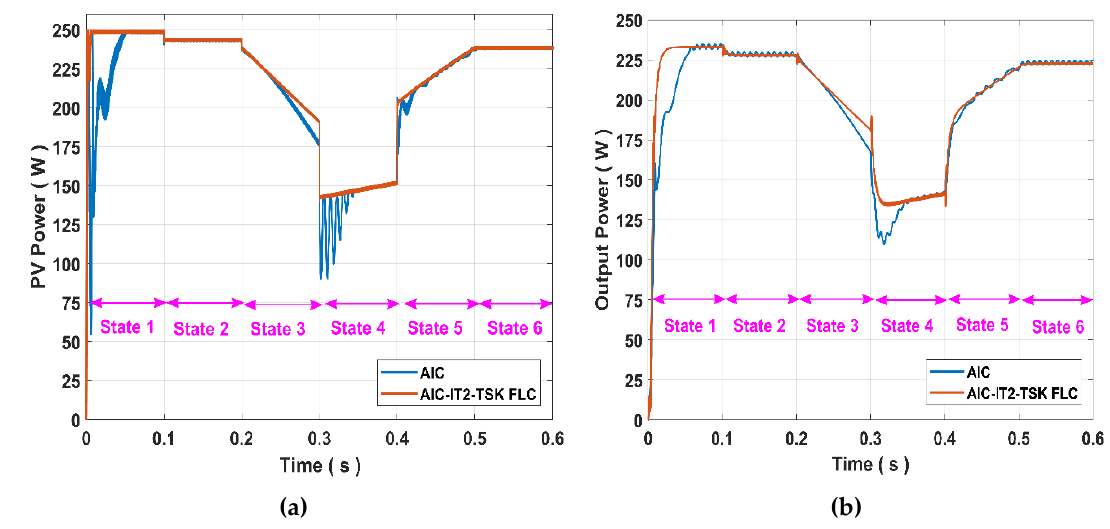
Figure 11. Output power responses of PV panel ( a ) and converter ( b ) for Case 2.